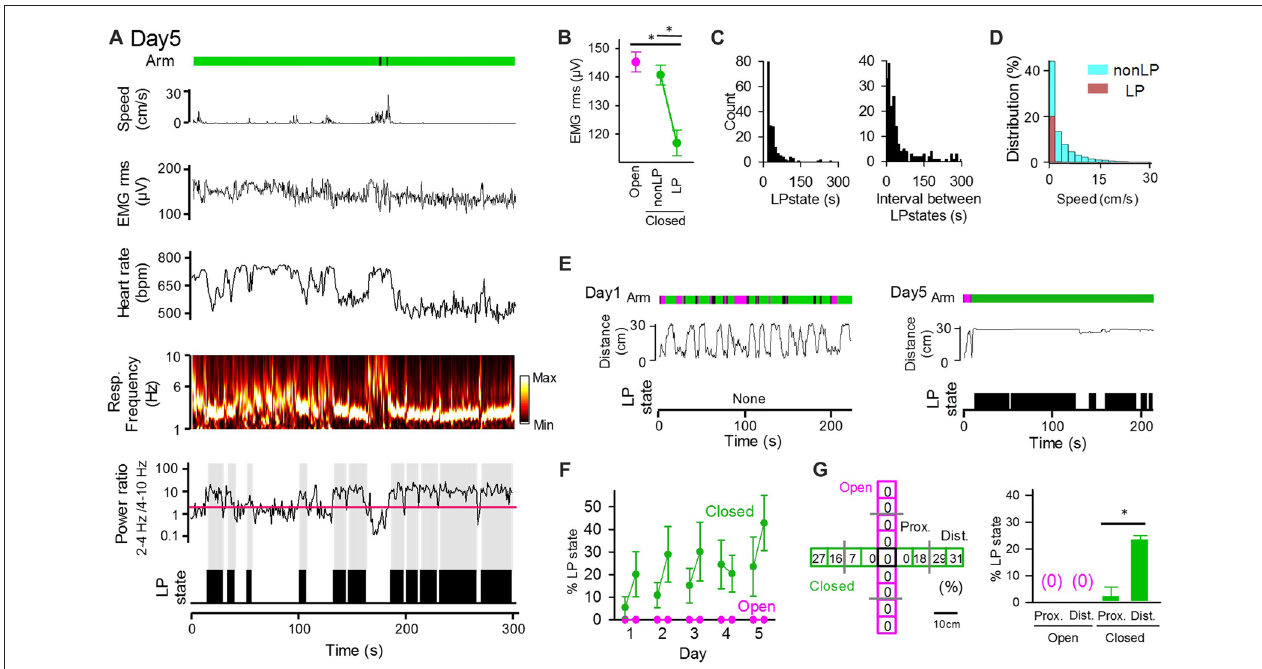
FIGURE 3 | The low peripheral (LP) states of peripheral activity in closed arms vary across sessions and days. (A) The same representative data as that shown in Figure 2A . The ratio of 2–4 Hz power to 4–10 Hz power of respiratory signals is shown under the power spectrum, with the red horizontal line indicating a ratio of 2. LP states are represented by black areas below the traces. (B) RMS of EMG signals in LP states and non-LP states. ∗ P < 0.001, paired t -test. (C) (Left) Distribution of the duration of single LP states. (Right) Distribution of the intervals of LP states. (D) Distribution of animal’s moving speed depicted separately in LP (brown) and non-LP states (cyan). (E) (From top to bottom) Arms wherein the animal was located at the same position as that in (A) , distance between the animal’s locations and the center of the maze, and periods of the LP states shown in (A) . (F) Average probability of LP states plotted for open and closed arms in individual sessions. The statistical results in these figures are described in the main text. (G) (Left) Each arm of the maze was divided into four regions, and the ratio of the duration of LP states to the total duration the animals spent in each region was calculated. (Right) Average probability of LP states plotted for regions wherein the animals were located. Proximal and distal regions were defined as regions with distances from the center of the maze less than and greater than 15 cm (the half length of an arms distance), respectively. ∗ P < 0.001, paired t